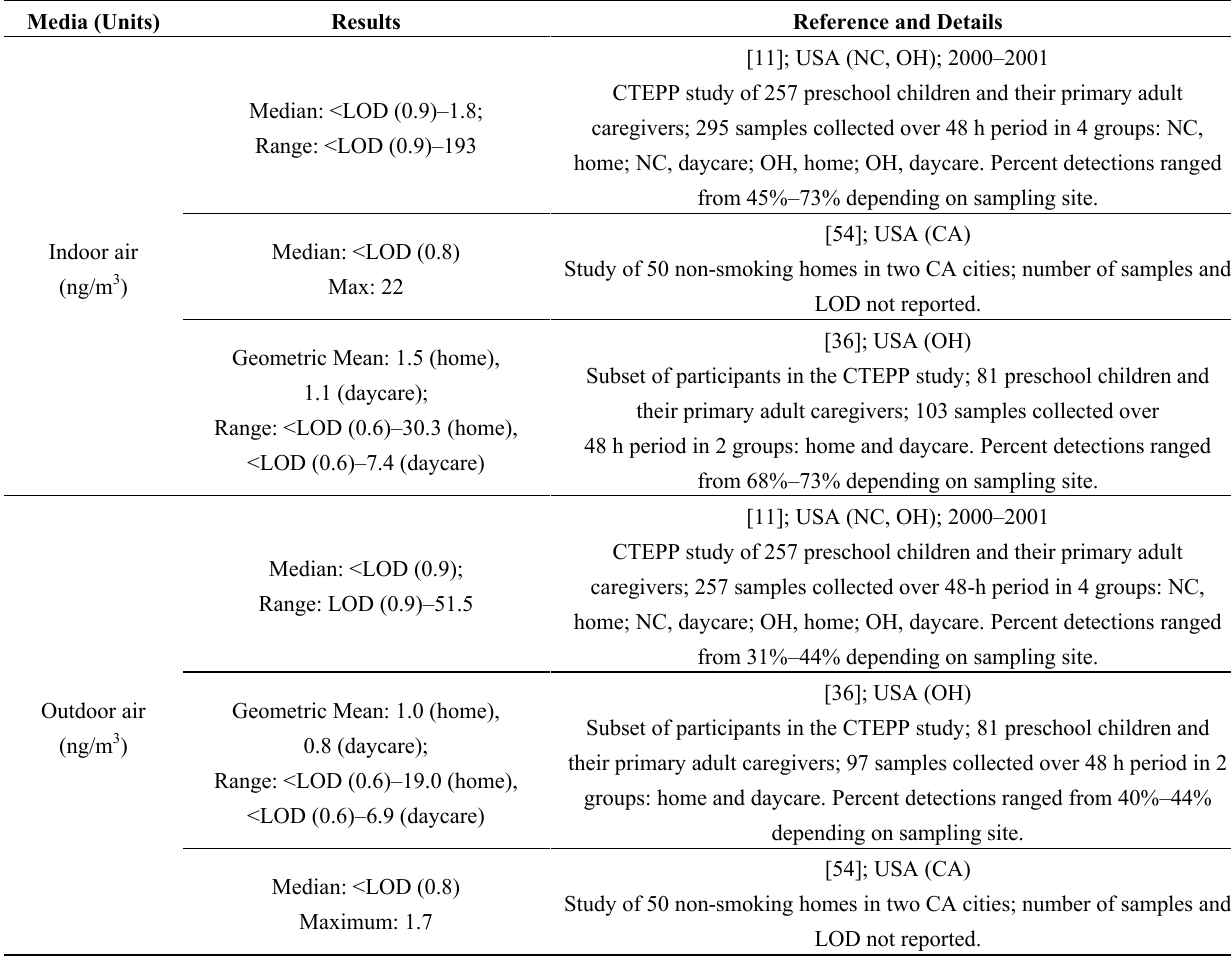
Table A1. U.S. studies reporting BPA concentrations in non-food